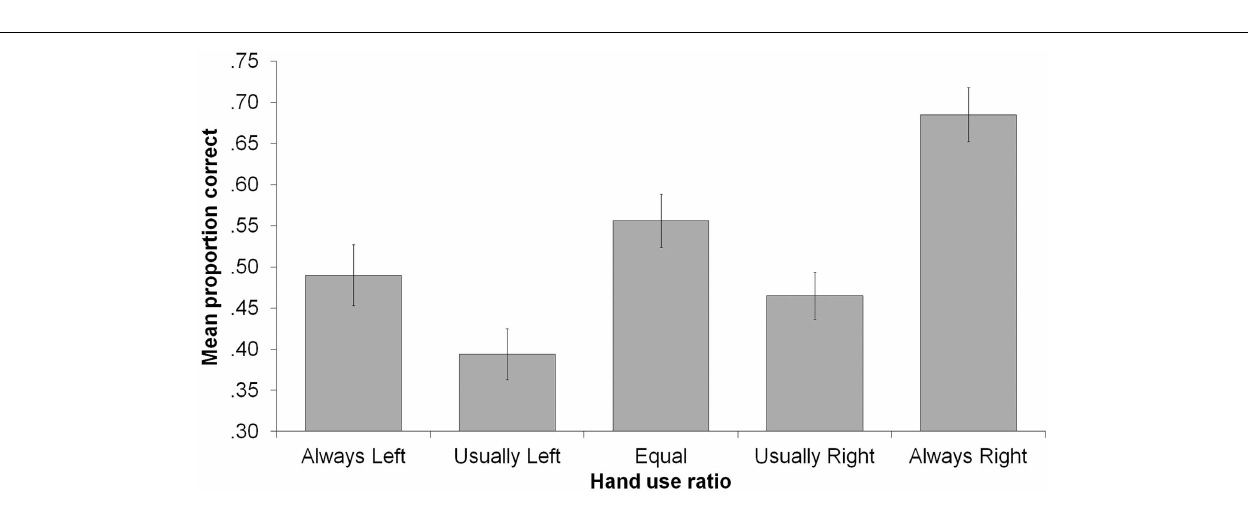
FIGURE 2 | Mean proportion correct as a function of hand-use ratio . Error bars indicate ± 1